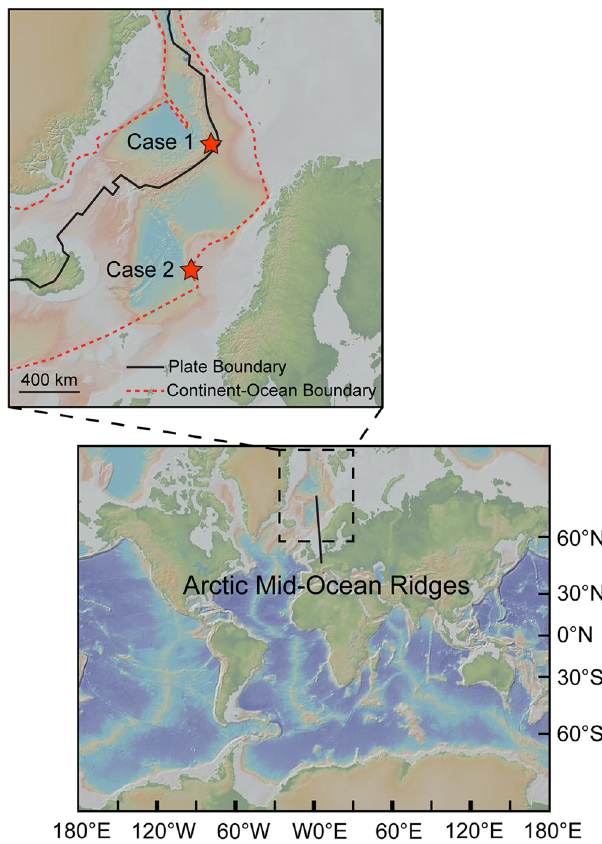
Fig. 1 Geographic overview over the study area. Case 1 is a Pliocene mid-ocean ridge gabbro while Case 2 is Cenozoic dacitic-tracydacitic sills that intruded Cretaceous sedimentary rocks. The black line and red dotted lines represent the plate boundary and the continent-ocean boundary, respectively. Maps were created using GeoMapApp